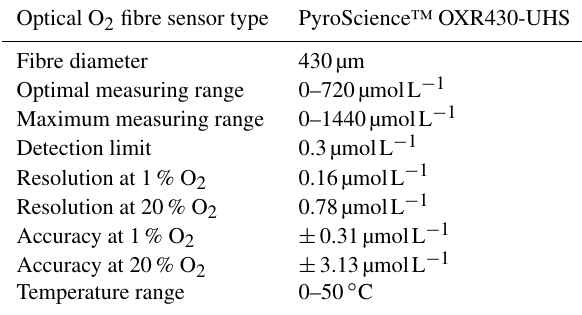
Table A1. Specifications of the PyroScience™ OXR430-UHS retractable oxygen mini sensors used in this study.